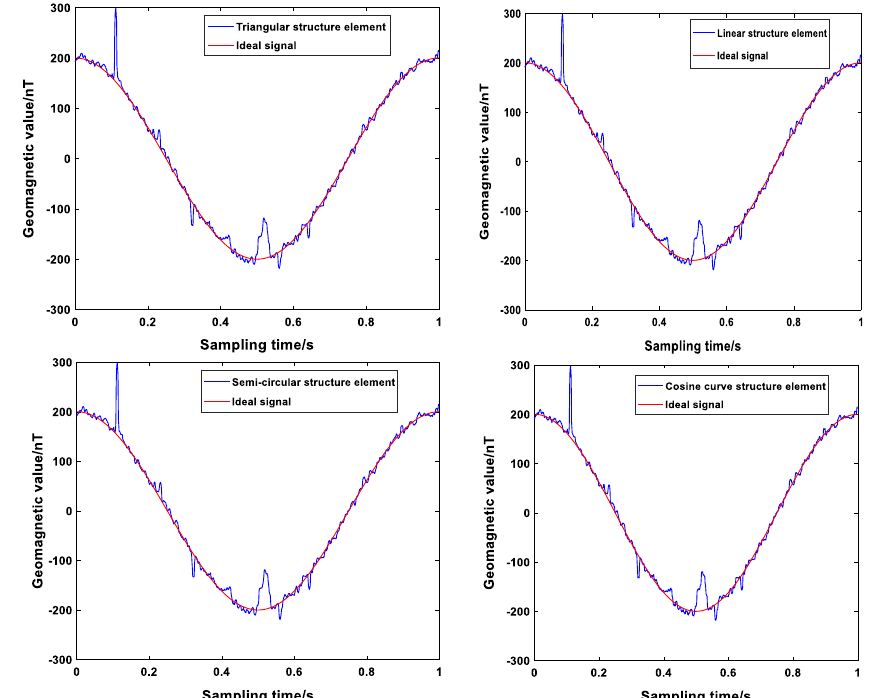
Fig. 3 Comparison of four structural elements